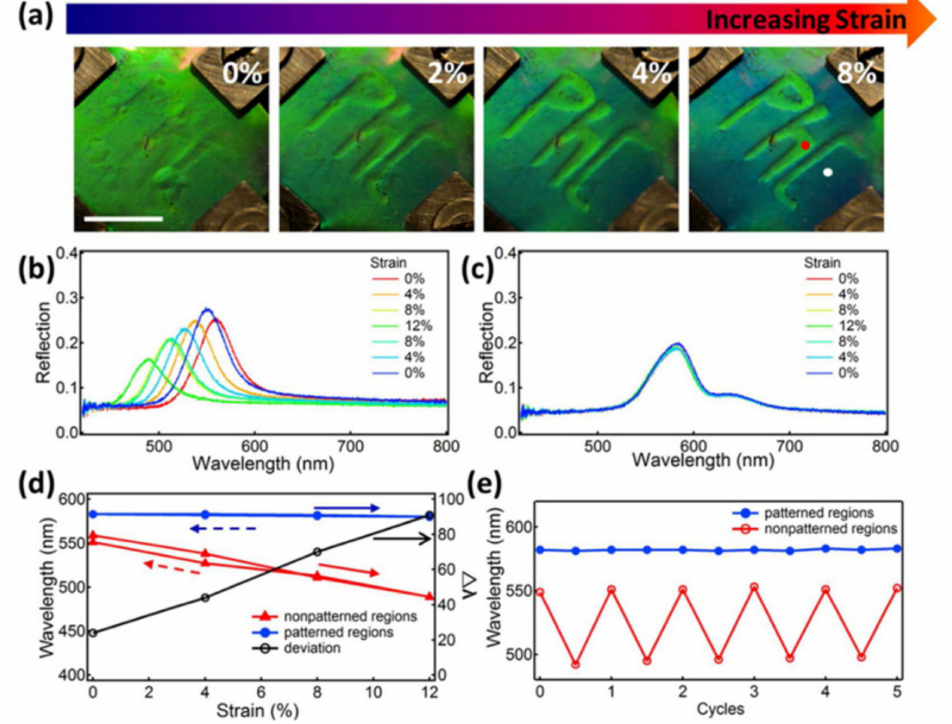
Figure 9. The invisible photonic print shown by mechanical stretching. ( a ) Invisible photonic print hidden in a relaxed state and shown by tensile state. Scale bar is 1 cm. ( b , c ) Reflection spectra in ( b ) background region and ( c ) pattern region under a stretch–release cycle. ( d ) The relationship between elongation and the reflection wavelength in the background region (red line) and the pattern region (blue line). The black line shows the relationship between elongation and the reflection wavelength di ff erence. ( e ) Reflection wavelength change in the pattern region (blue line) and background region (red line) in five cycles of the stretching–releasing test. Reused with permission from Reference [51], Copyright 2015, American Chemical